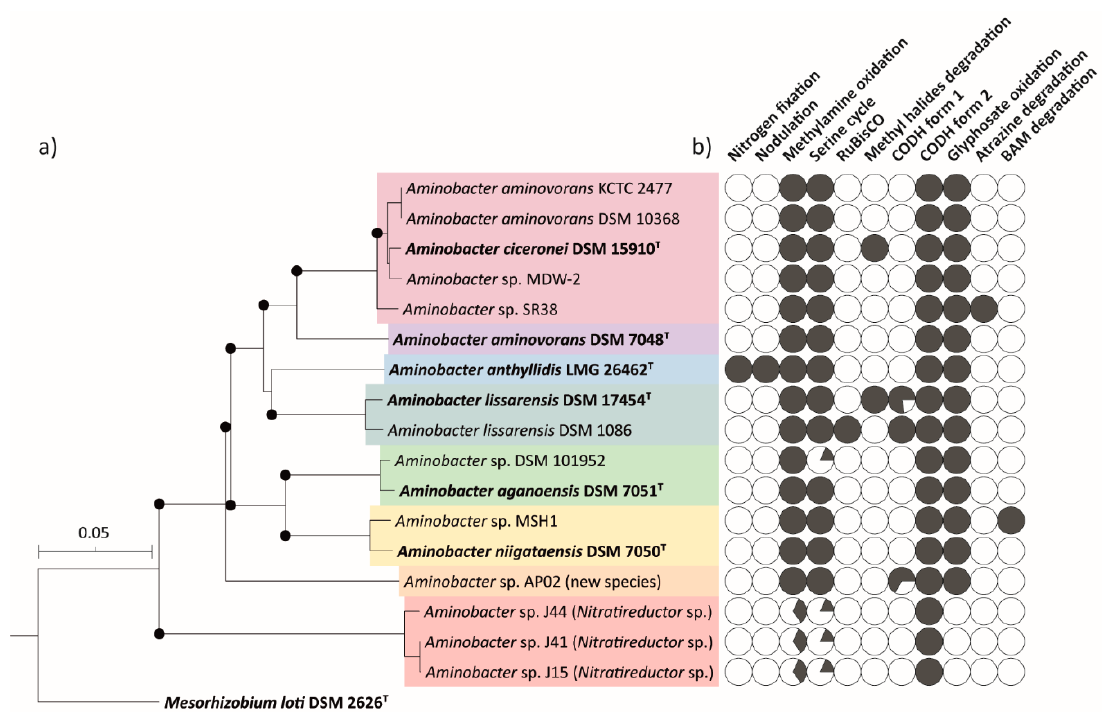
Figure 2. (a) Whole-genome phylogeny of the 17 Aminobacter strains, including all type strains of validly published species. M. loti DSM 2626 T was used as an outgroup. The branch lengths are scaled in terms of GBDP distance formula d ₅ . Filled circles at the nodes are GBDP pseudo-bootstrap support values > 70% from 100 replications. The scale bar indicates the number of substitutions per variable site. Each colored box contains Aminobacter members belonging to the same species, according to ANI and GGDC values (Figure 3); type strains are in bold. (b) Black sectored circles denote the presence and degree of completeness of genes involved in the metabolic pathways shown on top of the figure (each gene accounts for 1/22 sector for methylamine oxidation; 1/11 sector for serine cycle; 1/9 sector for CODH form I). White circles denote the complete absence of genes involved in the pathway.